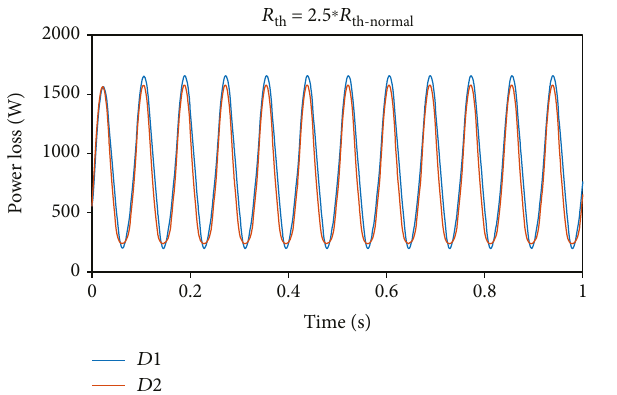
Figure 7: Junction temperature of parallel-connected power modules ( D 1 aged to 2 5 ∗ R th − normal ).